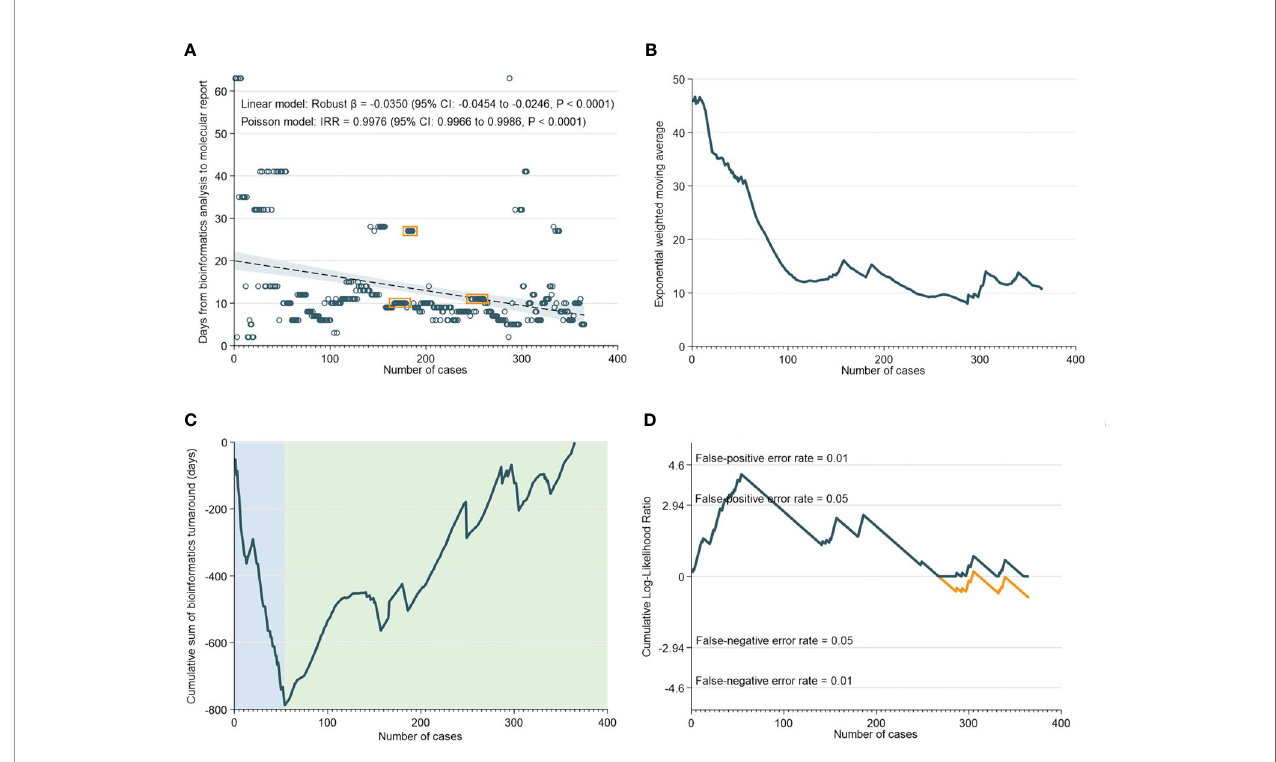
FIGURE 3 | Turnaround Time for Bioinformatics Analyses. (A) Scatter and regression fi t of bioinformatics turnaround vs case load. (B) Exponential weighted moving average of bioinformatics turnaround. (C) CUSUM of bioinformatics turnaround time. (D) CUSUM log-likelihood ratio chart for bioinformatics turnaround > 3